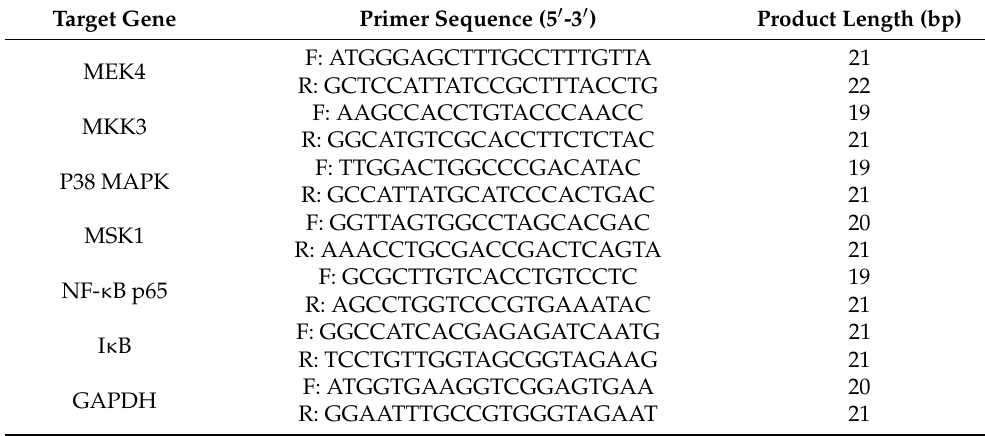
Table 1. Primers for quantitative real-time